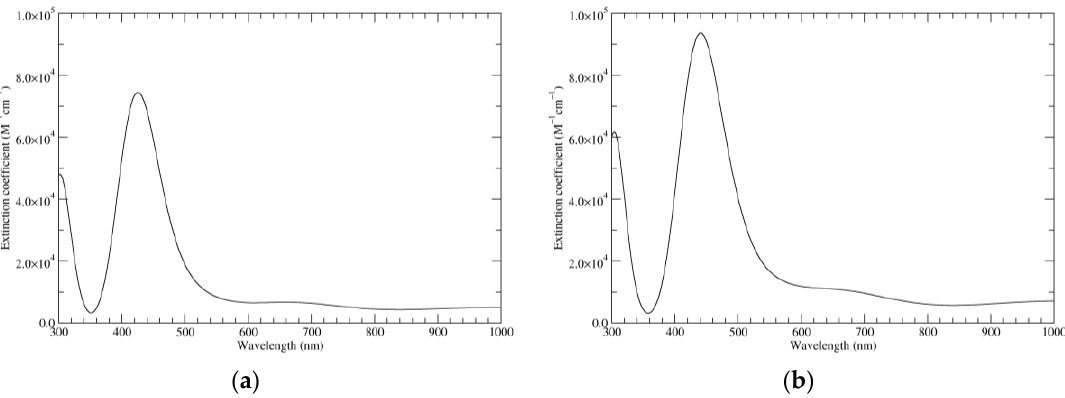
Figure 9. Computed UV–Vis spectra of the most significant tautomers/conformers in the six-electron oxidation state. ( a ) Neutral form in vacuo, a16_b6_c16_d6, C 2 , conf1. ( b ) Neutral form in water, a16_b6_c16_d6, C 2 , conf1.